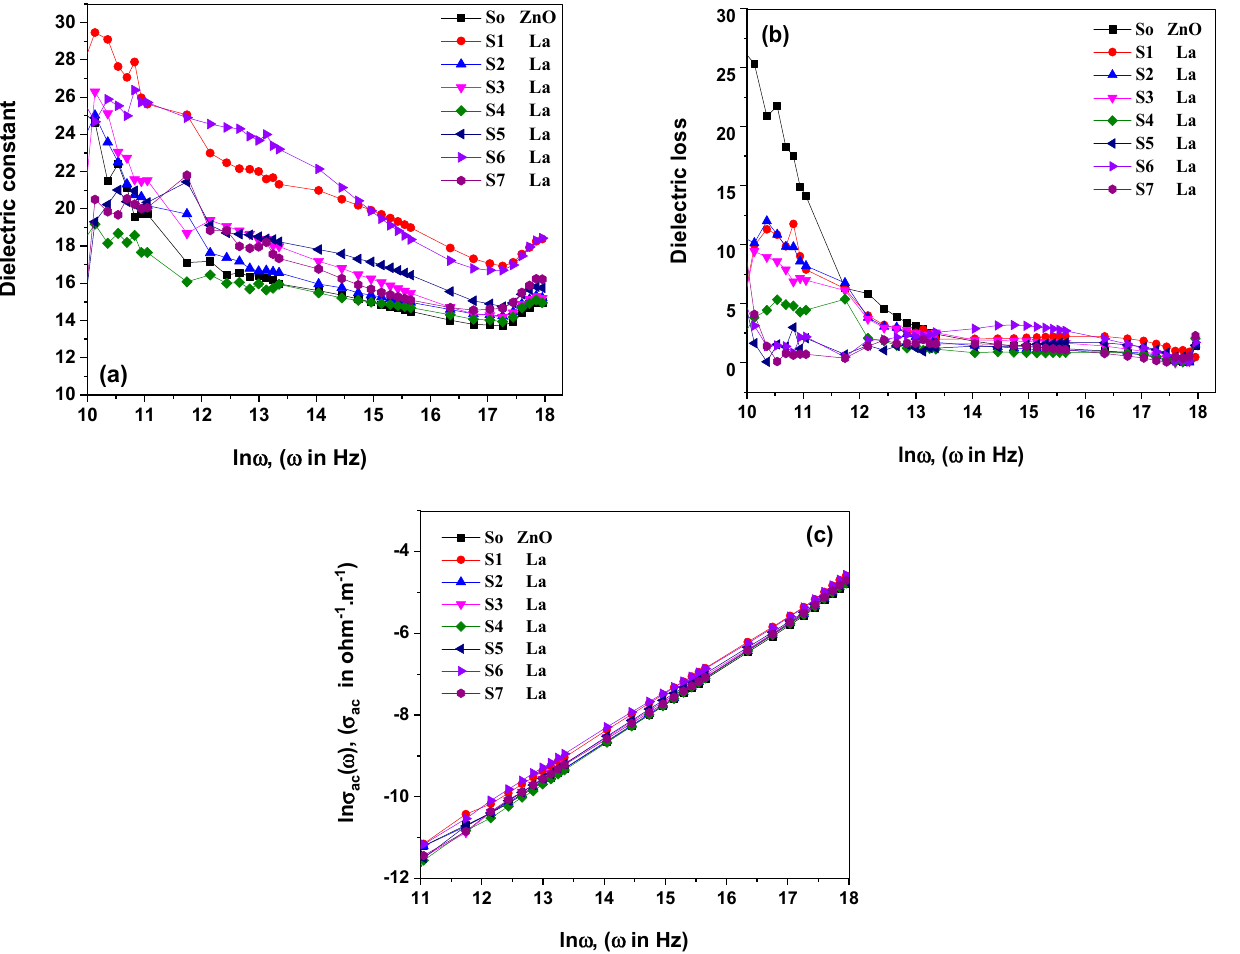
Figure 5. ( a – c ): ( a ) dielectric constant ( b ) dielectric loss ( c ) AC electrical conductivity ( h υ ) of the as-prepared La 2 O 3 -nanostructures .